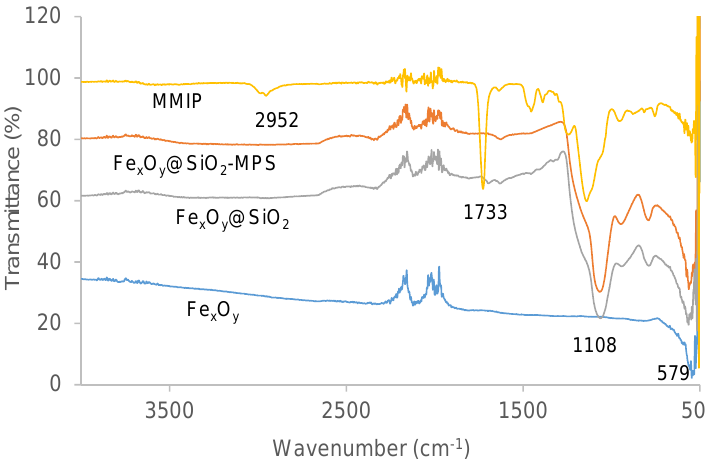
Figure 3. Overlaid Fourier transform ‐ infrared (FTIR) spectra of Fe x O y nanoparticles, Fe x O y @SiO 2 , Fe x O y @SiO 2 ‐ MPS, and putative MMIP. Fe x O y @SiO 2 : Fe x O y nanoparticles modified with SiO 2 ;